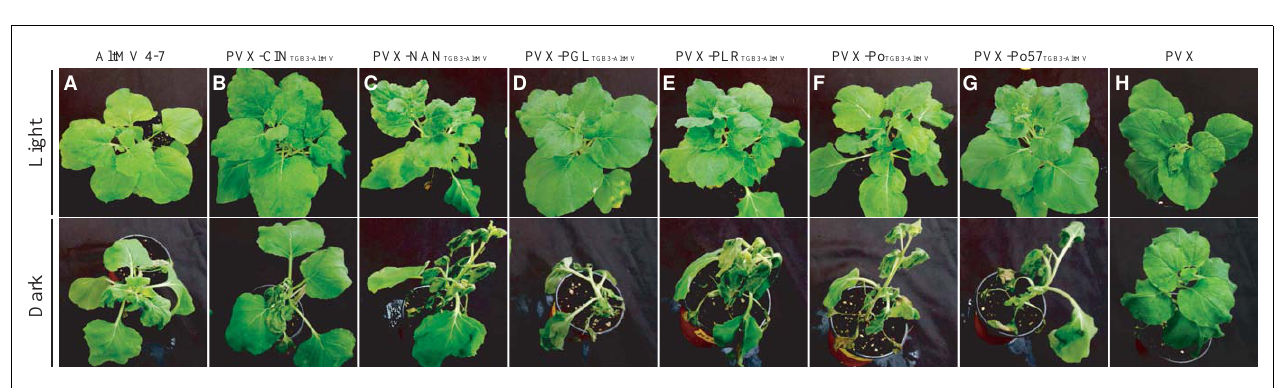
PVX-CIN TGB3-AltMV . (C) PVX-NAN TGB3-AltMV . ( D ) PVX-PGL TGB3-AltMV . (E) PVX-PLR TGB3-AltMV . (F) PVX-Po TGB3-AltMV . (G) PVX-Po57 TGB3-AltMV . (H) WT PVX (negative control). Note increased severity of symptoms in dark-grown plants over-expressing AltMVTGB3 variants, with collapse of apical leaves, whereas AltMV 4–7 (A) shows slightly more severe symptoms, andWT PVX (H) shows minimal increase in symptom severity compared to light-grown